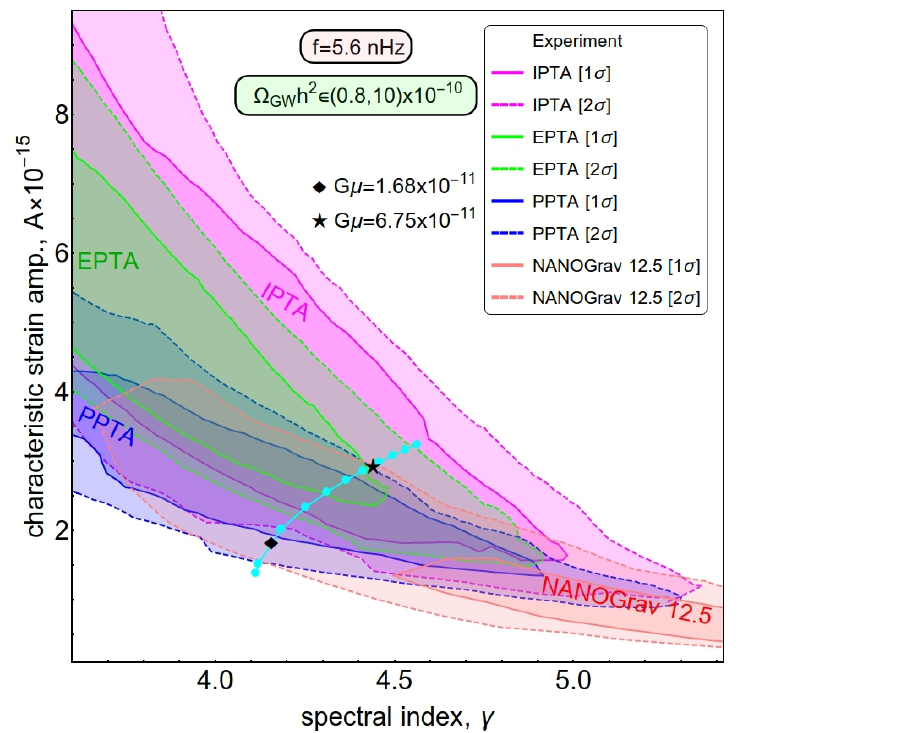
Figure 4 . A combined fit (cyan curve) to NANOGrav, PPTA, EPTA, and IPTA data in the ( A, γ ) plane. The diamond and the star shaped points are the two chosen benchmark scenarios of the proposed model. See text for